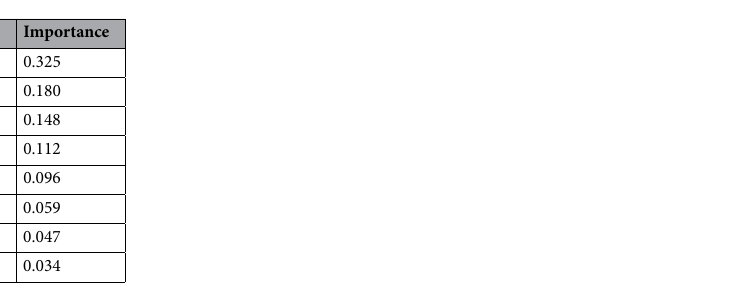
Table 6. Importance of variables in the proposed gastric cancer screening model.